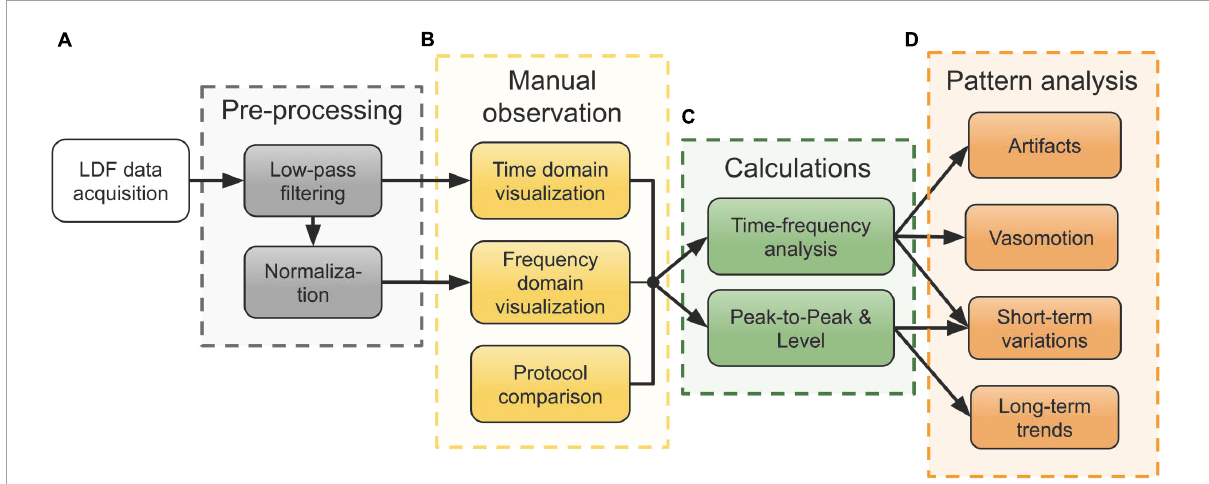
FIGURE2 Workflow of the processing steps of data acquired in the neurointensive care unit (NICU). (A) Pre-processing of the raw laser Doppler flowmetry (LDF) data. (B) Manual observation of the signals in both the time and frequency domain, compared with the measurement protocol notes. (C) Time-frequency analysis using wavelets and computation of peak-to-peak (P-P) and level of the perfusion signal for further analysis of patterns. (D) Analysis of various patterns seen during the manual observation using the results from panel (C)